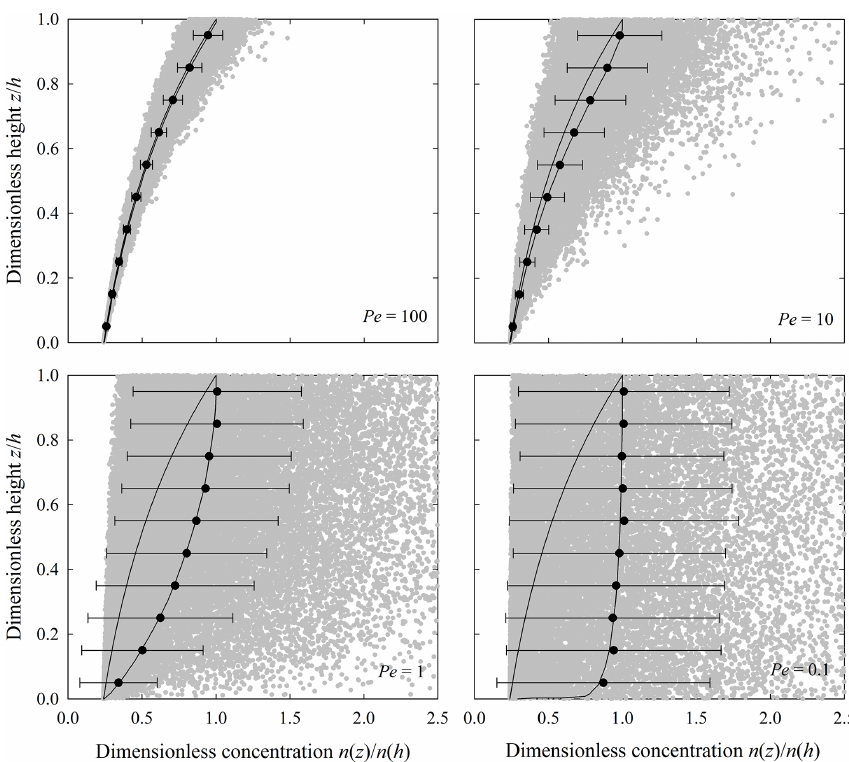
Figure 4. Plot of dimensionless 10 Be concentration ˆ n = n ( z ) /n ( h ) versus dimensionless height ˆ z = z/h showing simulated particle concen- trations ˆ n p (gray dots) for Pe = 100 , 10 , 1 , 0 . 1, and estimates of expected concentrations ˆ n averaged within 0 . 1 h intervals (black circles) with one standard deviation bars. Simulations represent nonuniform mixing with κ z = K z z/h . Right solid line is the theoretical result, and left solid line represents the absence of